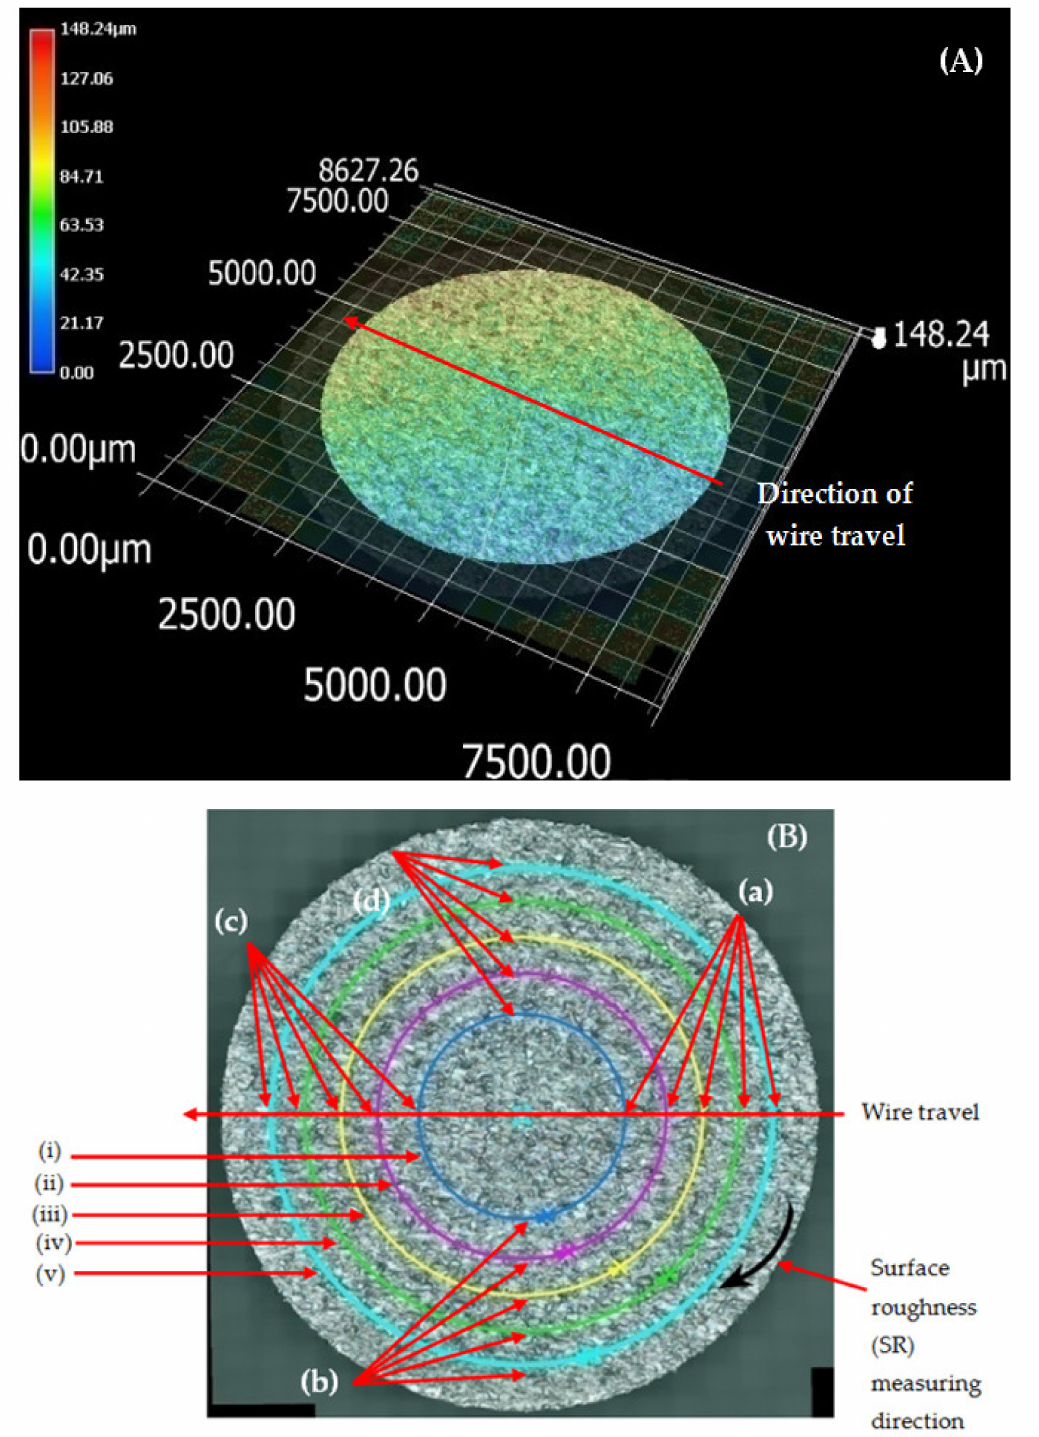
Figure 3. ( A ) Wire-travel direction; ( B )Surface analysis for sample at outer